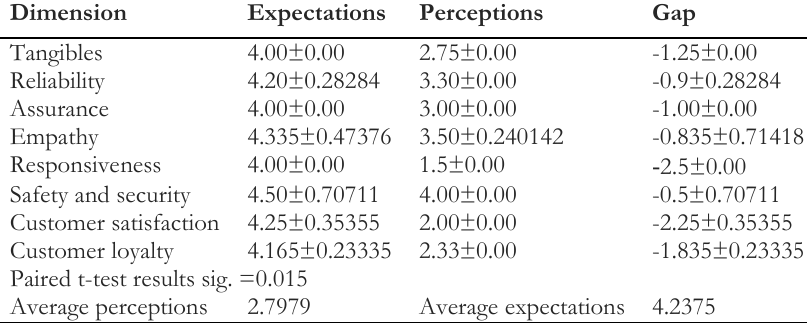
Table 7. Gap quality analysis of reverse support services - unit 4.